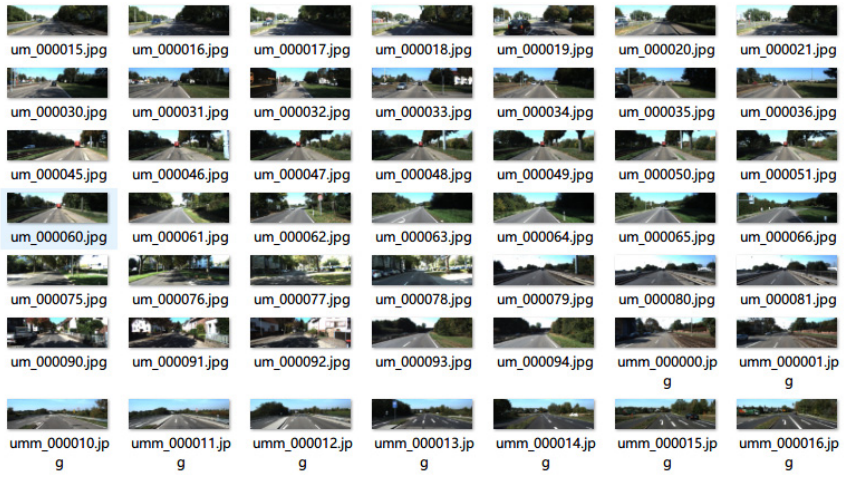
Figure 1. Portioned images extracted from the dataset.